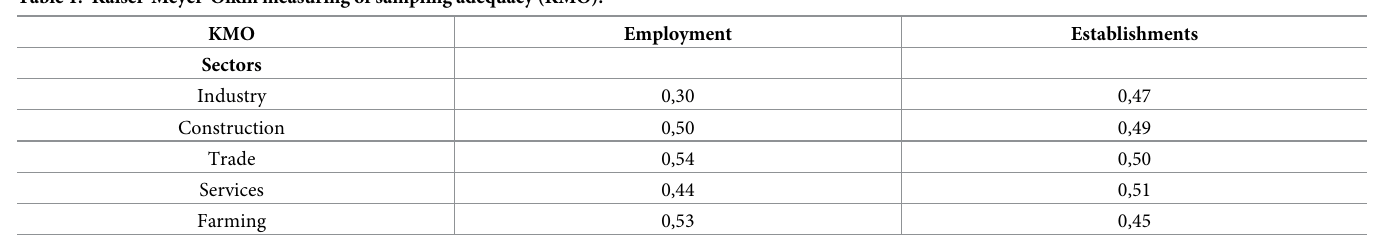
Table 1. Kaiser-Meyer-Olkin measuring of sampling adequacy (KMO).